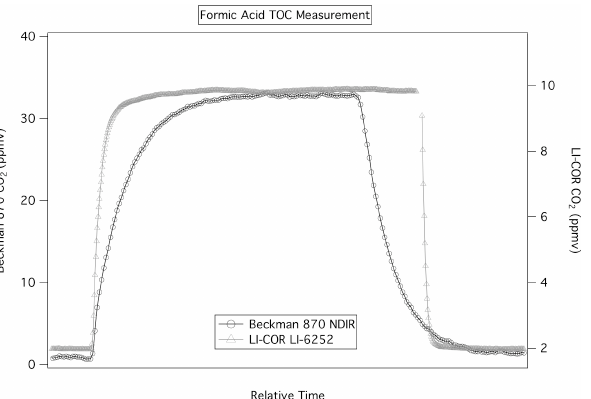
1 2 Figure 7. Formic acid measurement comparison using MOCCS with the Beckman model 870 3 Fig. 7. Formic acid measurement comparison using MOCCS with NDIR CO 2 analyzer and the LI-COR LI-6252 CO 2 analyzer. The TOC system was set to a 1- 4 the Beckman model 870 NDIR CO 2 analyzer and the LI-COR LI- 6252 CO 2 analyzer. The TOC system was set to a 1-h cycle between hour cycle between CO 2 catalysis measurements and background measurement. Significant 5 CO 2 catalysis measurements and background measurement. Sig- improvements in both CO 2 detection limit and instrument response times are achieved with the 6 nificant improvements in both CO 2 detection limit and instrument LI-COR LI-6252 analyzer. It is important to note that the two CO 2 measurements are not of the 7 response times are achieved with the LI-COR LI-6252 analyzer. It same formic acid standard, which explains the difference in left and right axes. 8 is important to note that the two CO 2 measurements are not of the same formic acid standard, which explains the difference in left and right